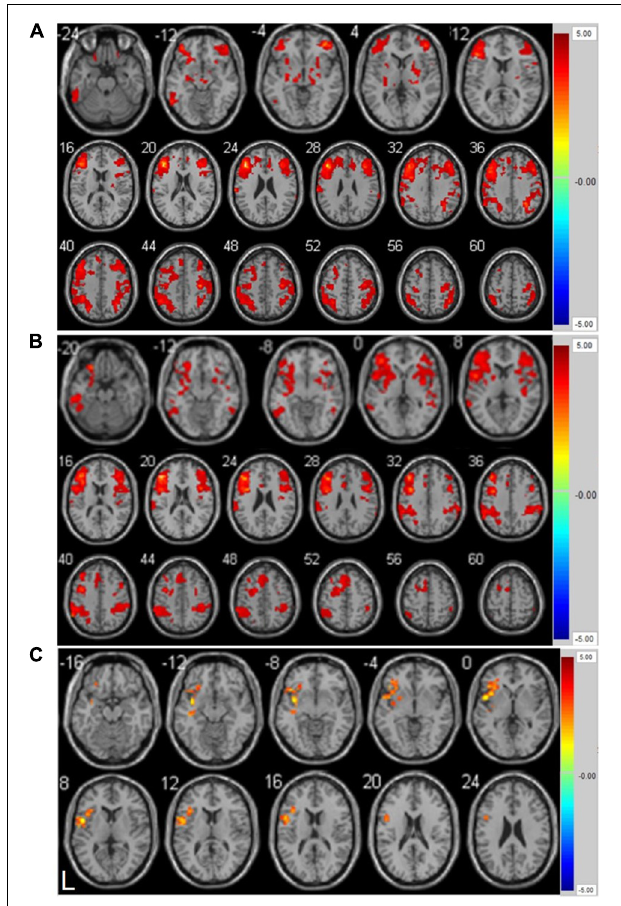
FIGURE 2 | (A) Positive resting-state functional connectivity with left DLPFC pre-ER intervention in PD patients. (B) Positive resting-state functional connectivity with left DLPFC post-ER intervention in PD patients. (C) Differential positive resting-state functional connectivity with left DLPFC between pre- and post-ER intervention in PD patients ( p < 0.05, Alphasim corrected, cluster size > 228 voxels). Abbreviation: ER, enriched rehabilitation.